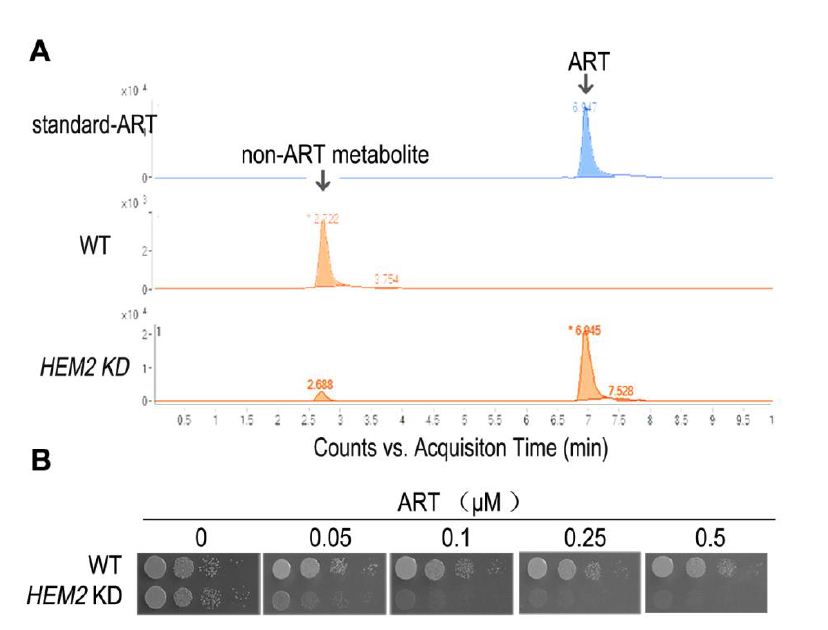
FIGURE 2: Heme is a major ART-reactive agent inside cells. (A) Heme knockdown significantly suppresses the rate of ART metabolism in yeast. Shown is a HPLC anal- ysis of ART after incubation with growing yeast cultures. Heme knockdown ( HEM2 KD ) reduces the rate of ART consumption. (B) Heme knockdown dramatically increas- es, instead of decreases, the potency of ART in inhibiting mitochondrial actions (so that the yeast growth on non-fermentable media is restricted). When heme level is reduced, ART inhibition of yeast can be observed in 50 nM on the non-fermentable agar plate. Part of this figure is adapted from reference